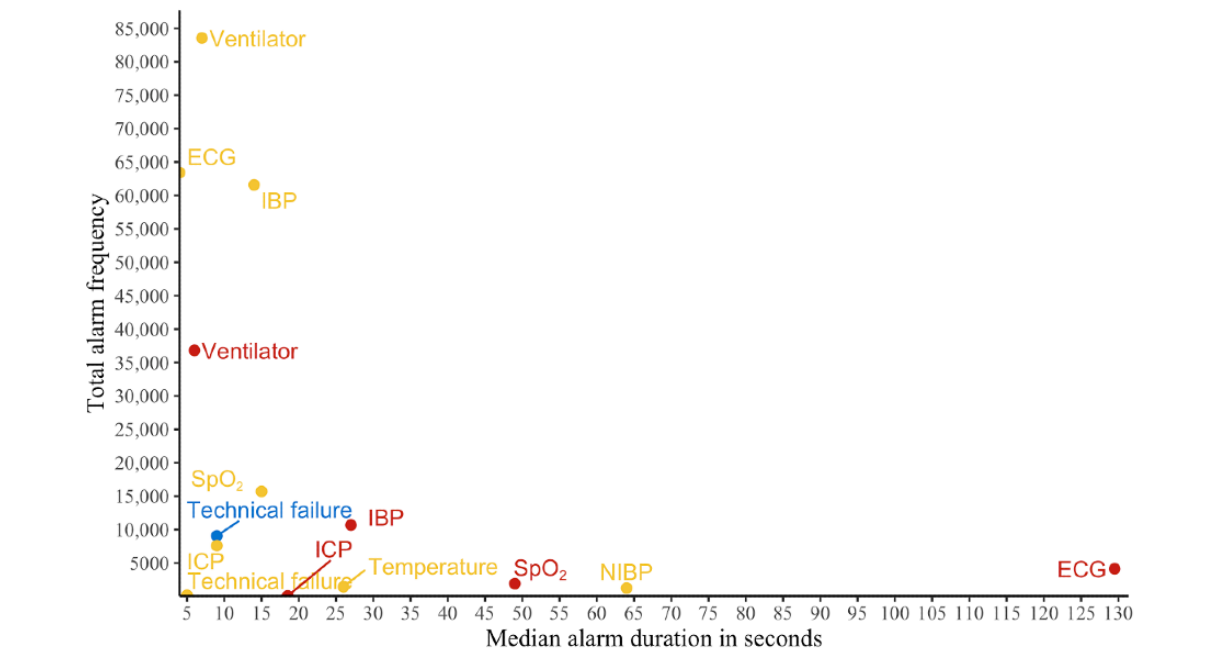
Figure 7. The median alarm duration from 8 medical devices plotted against the total number of alarms issued by the respective device. The colors correspond to the alarm criticalities (red, yellow, and blue). ECG: electrocardiogram; IBP: invasive blood pressure; ICP: intracranial pressure; NIBP: noninvasive blood pressure; SpO 2 : oxygen